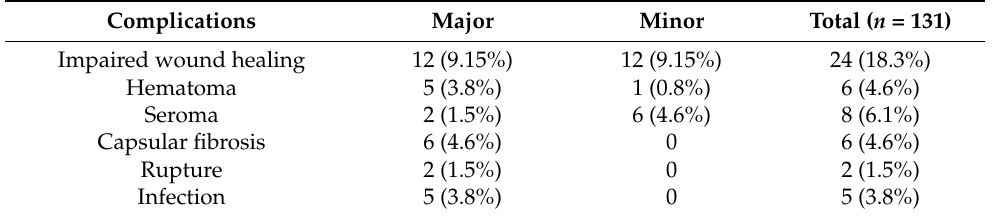
Table 1. Postoperative